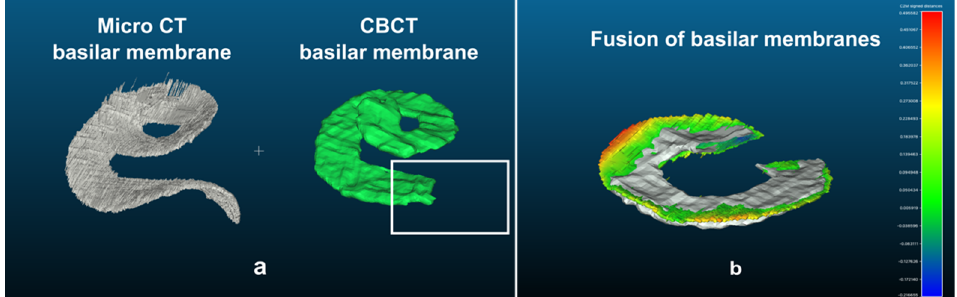
Figure 4. Comparison of basilar reconstruction segmented from micro-CT images and CBCT. The term basilar membrane represents the middle plane of the cochlear turn which includes the basilar membrane and the spiral lamina. ( a ) The hook region has not been segmented on CBCT images because of its complexity (open square); ( b ) the distance between both segmented “basilar membranes” (both cropped from 90° to 540°) was calculated. The color scale represents the distance between both basilar membranes, from green (shorter gap) to red (greater gap). In grey, both basilar membranes are superposed.